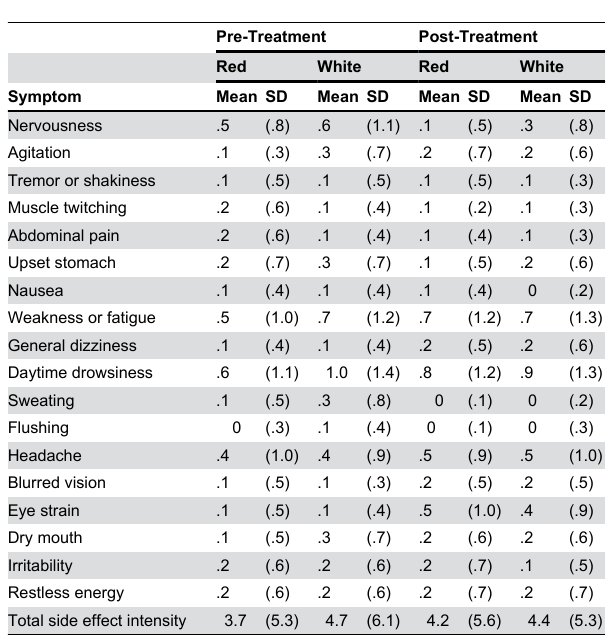
Table 1. Average Side Effect Intensity for Dim Red and Bright White Light at Pre-Treatment and